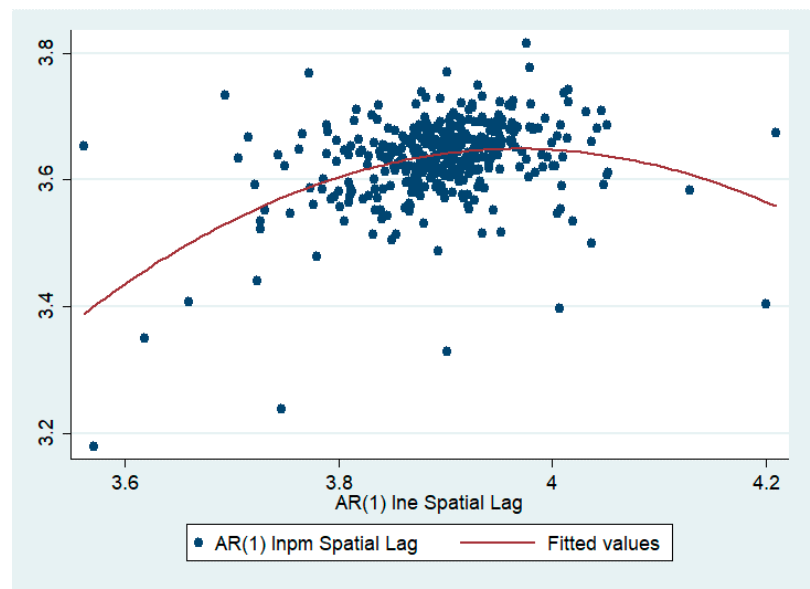
Figure 2. Nonlinear scatter fit graph of innovation efficiency and haze pollution.